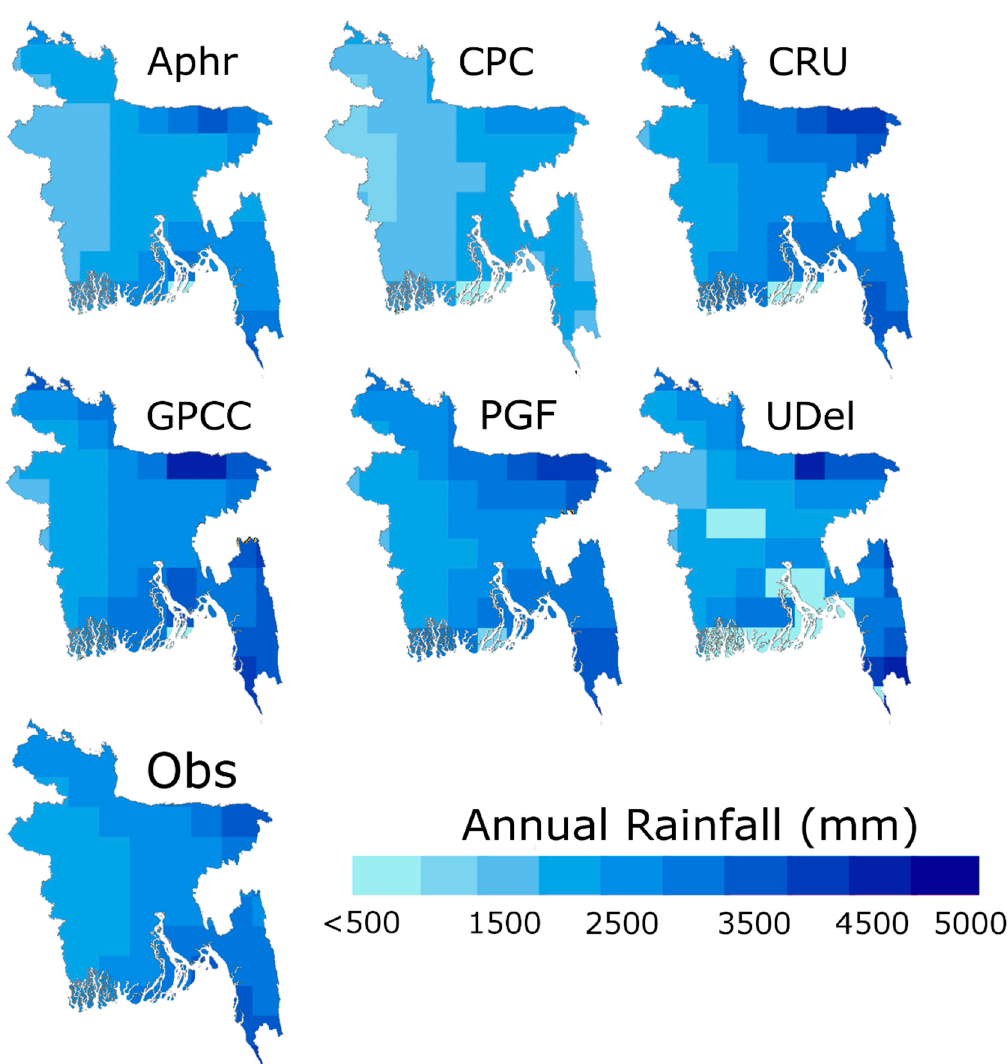
Figure 2. Spatial distribution of average annual rainfall in Bangladesh during 1979–2010 obtained using different gridded and interpolated observed (Obs) rainfall data at a resolution of 0.5° × 0.5°.